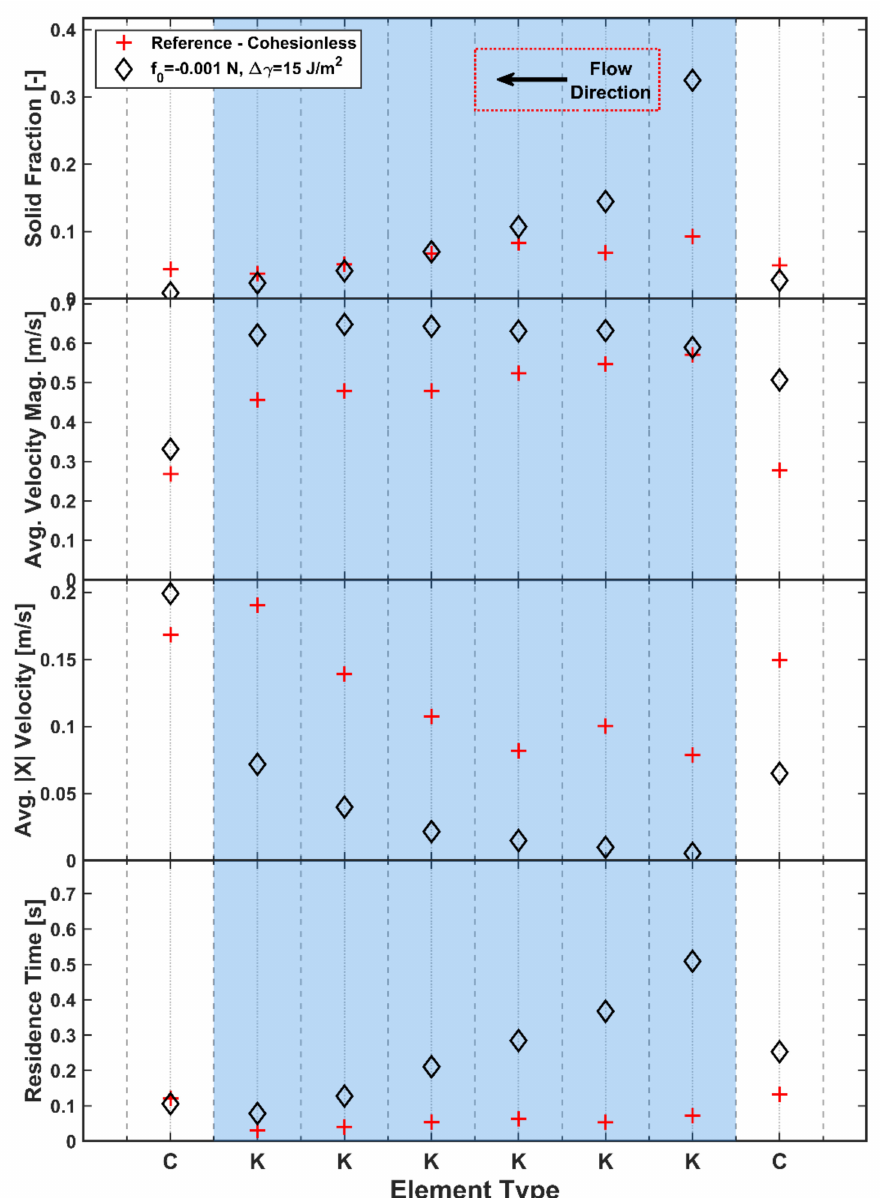
Figure 16. Effect of level of cohesion on solid fraction, velocity and residence